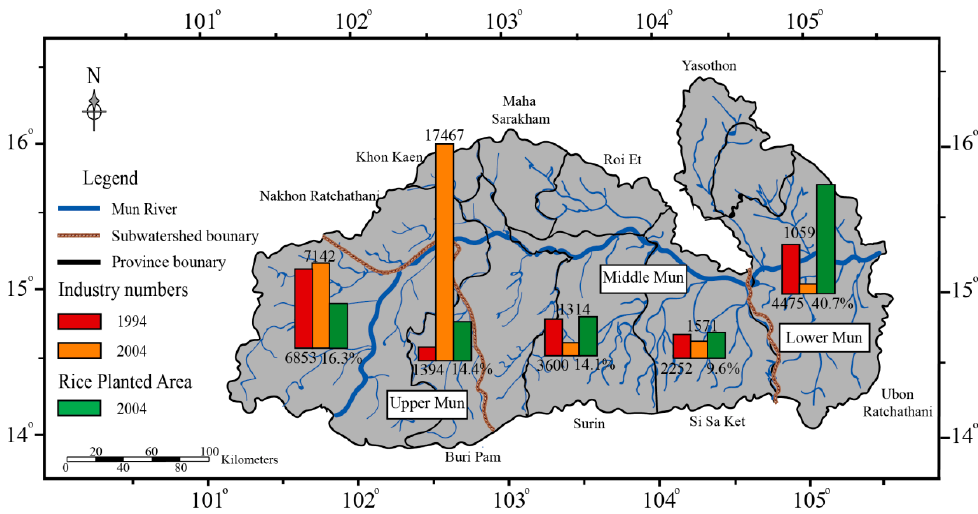
Figure 2. Percentage of industries and rice field in the Mun River Basin.